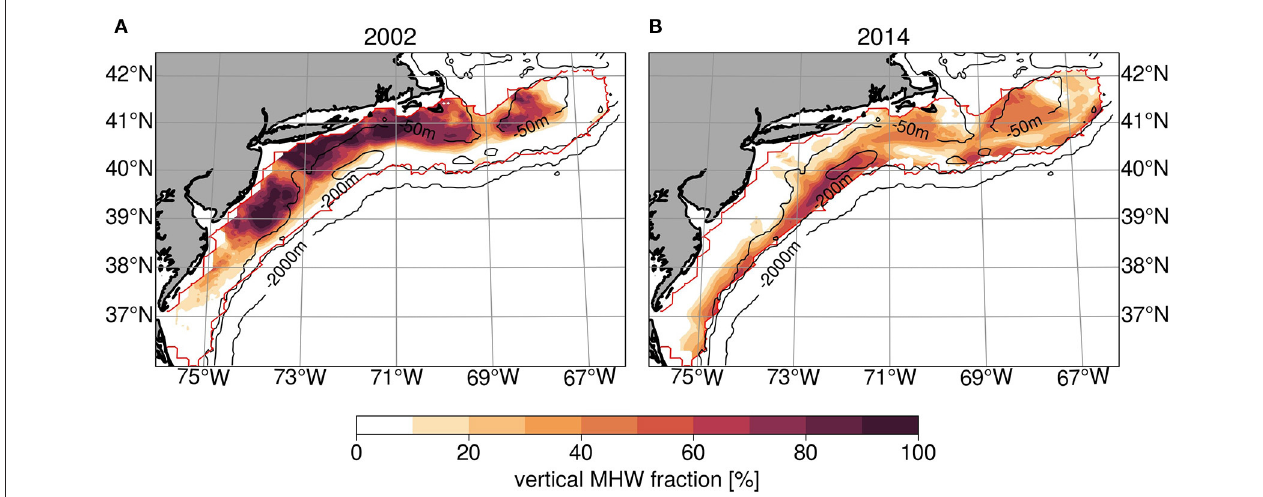
FIGURE 10 | Vertical MHW fraction of events in 2002 (A) and 2014 (B) ; temporal and depth-weighted mean of MHW occurrence; dashed lines indicate isobaths for 50, 200, and 2,000 m depth. Note that only data within the red outline (ecoboxes) is used